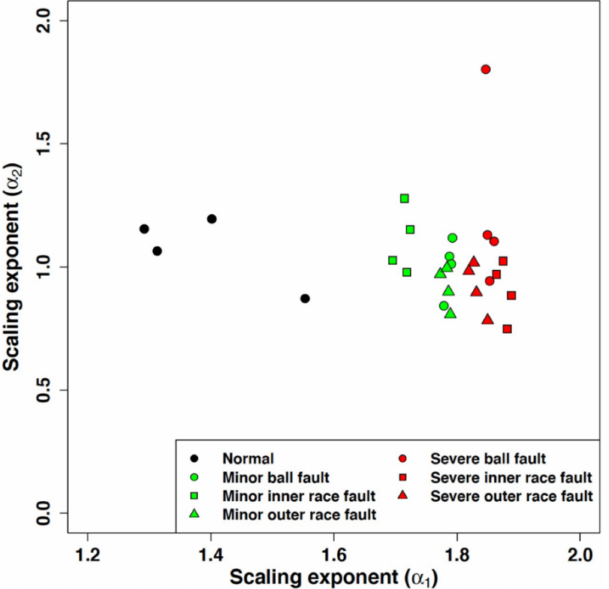
Figure 6. Scaling exponents of bearing vibration signals (48,000 samples/s) at short- and long- time scales.